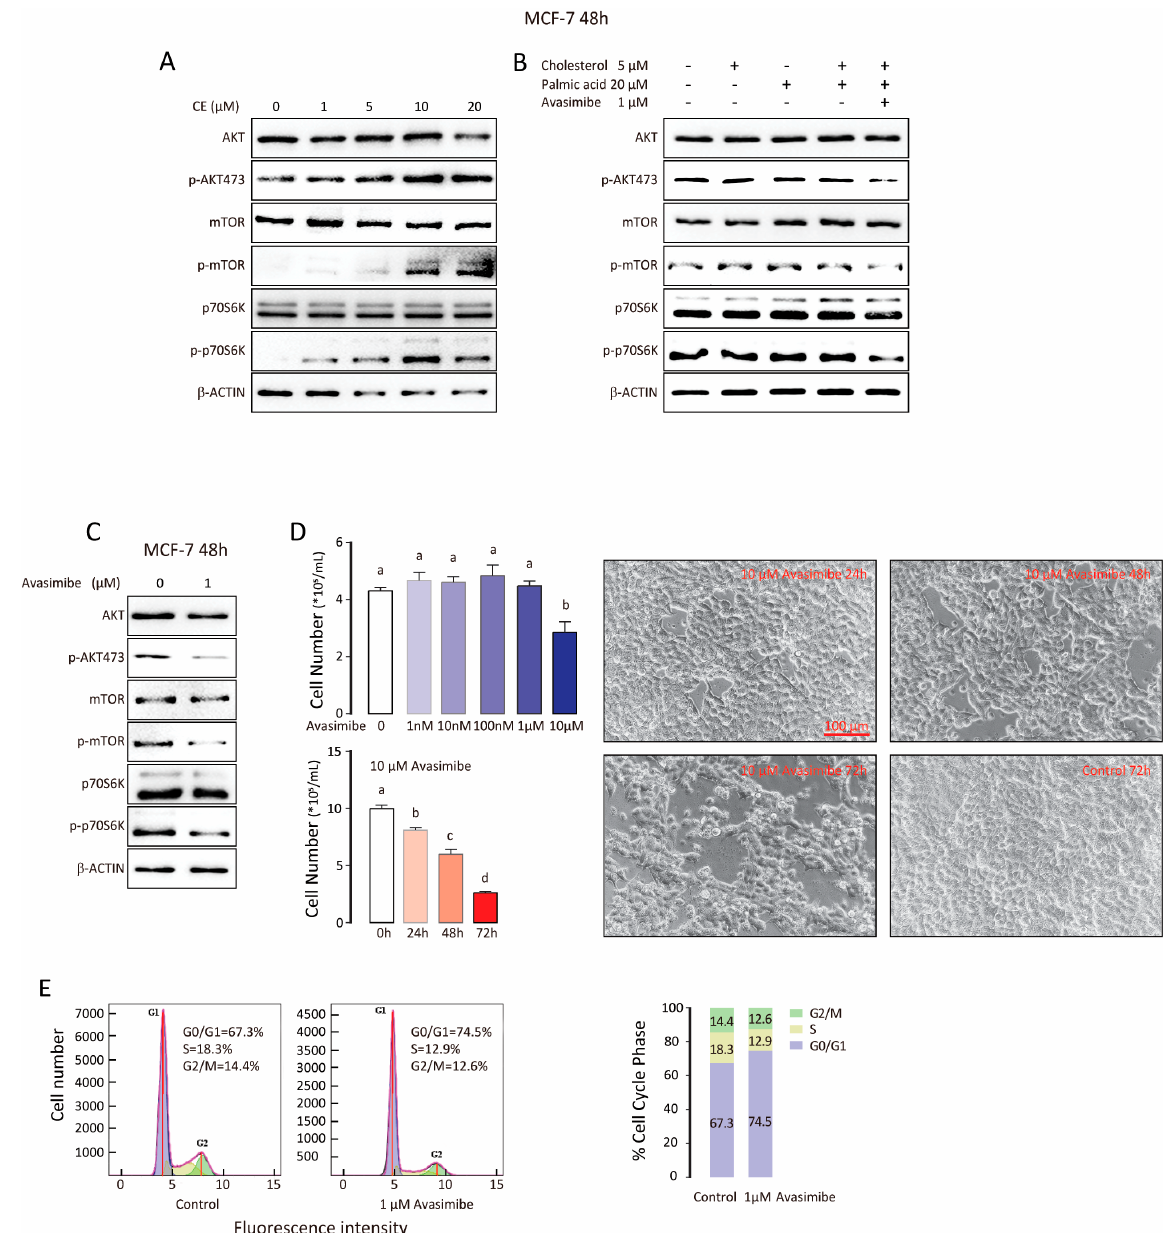
Figure 4. CE synthase inhibitor reduces AKT and mTOR activation and suppress tumor cell growth. ( A ) Expression of p-AKT, total AKT, p-mTOR, total mTOR, p-p70S6K, and total p-70S6K proteins in MCF-7 cells treated with cholesteryl ester. β -Actin was used as loading control. ( B ) Expression of p-AKT, total AKT, p-mTOR, total mTOR, p-p70S6K and total p-70S6K proteins in MCF-7 cells treated with cholesterol or palmic acid alone or in combination with or without SOAT1 inhibitor avasimibe. ( C ) Expression of p-AKT, total AKT, p-mTOR, total mTOR, p-p70S6K, and total p-70S6K proteins in MCF-7 cells treated with 1 μ M avasimibe. β -Actin was used as loading control. ( D ) Dose/time dependent cell proliferation after treatment with or without avasimibe. ( E ) Cell cycle analysis after treatment with or without avasimibe. For experiments where necessary, ANOVA (Tukey’s test) was performed and p < 0.05 was considered as significant. Values (means ± S.E.M.) with different letters indicate statistical significance.